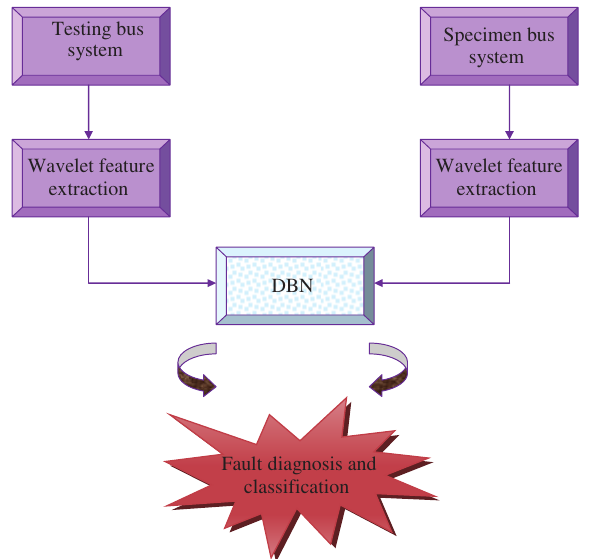
Figure 1: Architecture of Proposed Fault Diagnosis and Classification